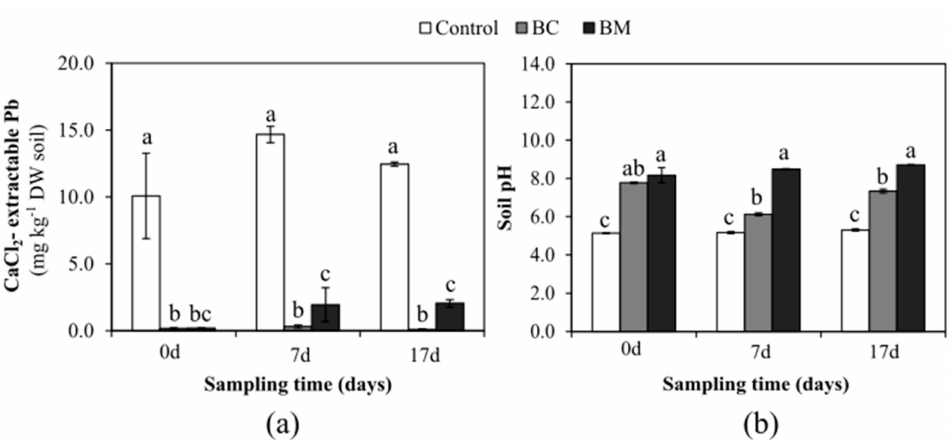
Figure 2. ( a ) CaCl 2 -extractable Pb concentrations and ( b ) pH of control soil and BC- and BM-amended soils at 0, 7 and 17 days after amendment application, under field conditions. Error bars represent standard errors. Different lower case letters above error bars indicate significant differences at p < 0.05 among means of different